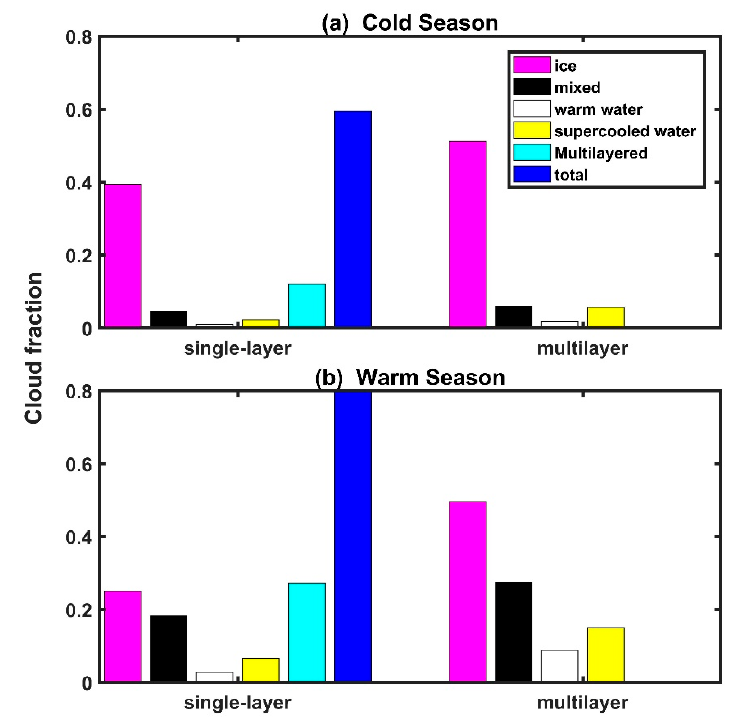
Figure 4. Four-year cloud fraction of different cloud phases over the TP (The first four columns represent the ice cloud, the mixed-phase cloud, the warm water cloud, and the supercooled water cloud, respectively, and represent only a single-layer, while the last four columns represent multi- layer condition. And the multilayer condition further classifies the multilayered clouds into four different cloud phases if the multilayered clouds include the given cloud phases. In addition, the left column has total clouds and multilayered clouds, ( a ) represents the cold season, and ( b ) represents the warm